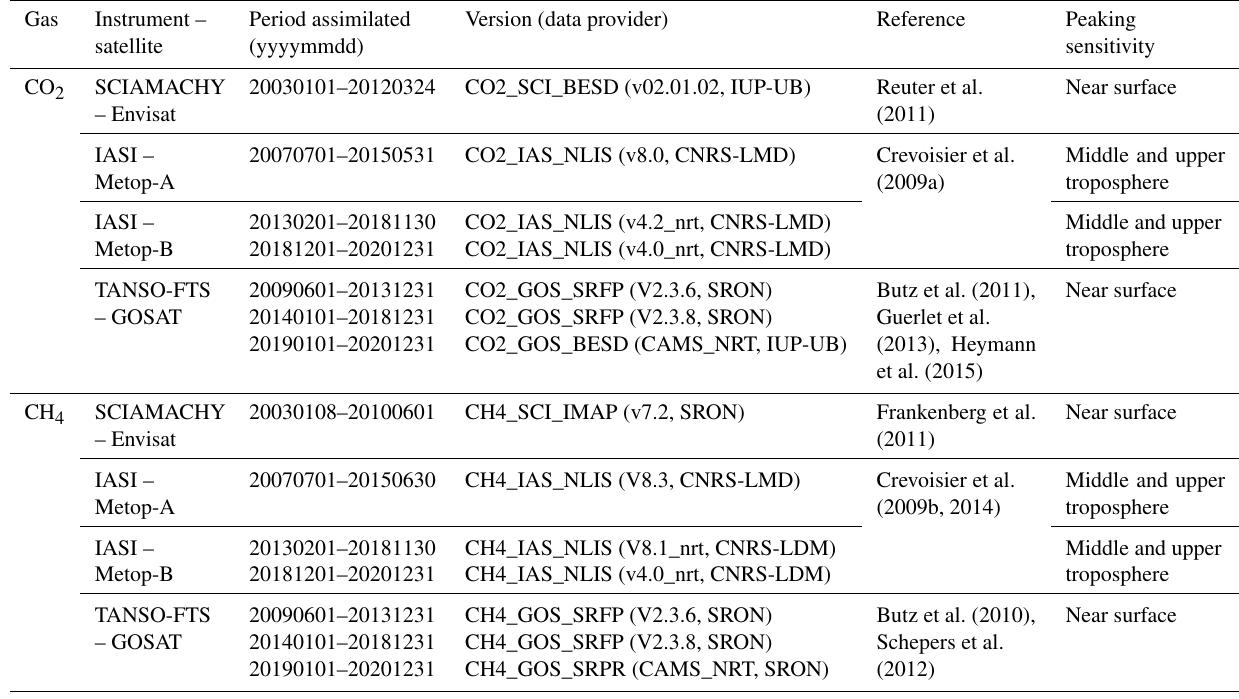
Table 1. Specifications of the satellite data used in the CAMS GHG reanalysis.